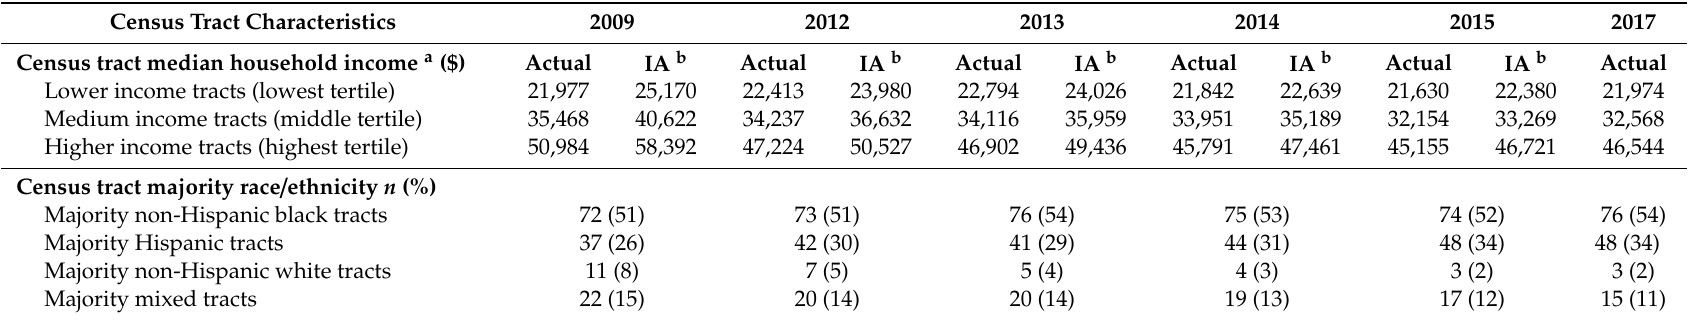
Table 1. Demographic characteristics of the 142 census tracts included in the analysis of food access in four New Jersey